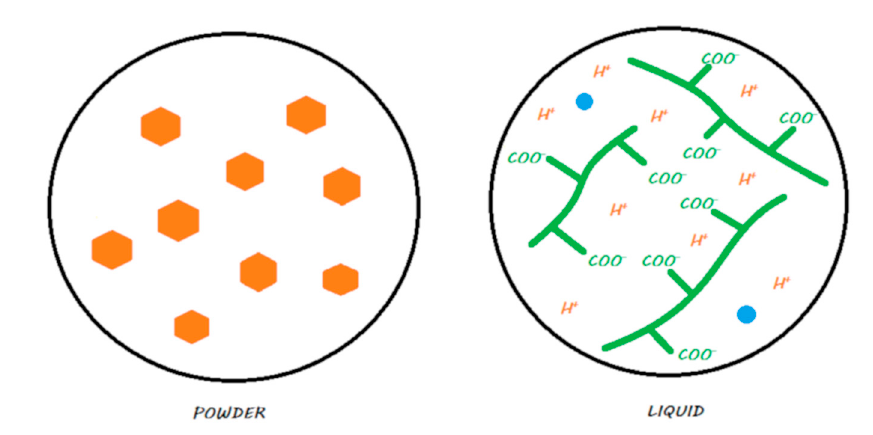
Figure 2. Conventional GIC in its storage medium. The powder contains FAS fillers that are not silanated, whereas the liquid contains water and ionized polyacrylic acids.